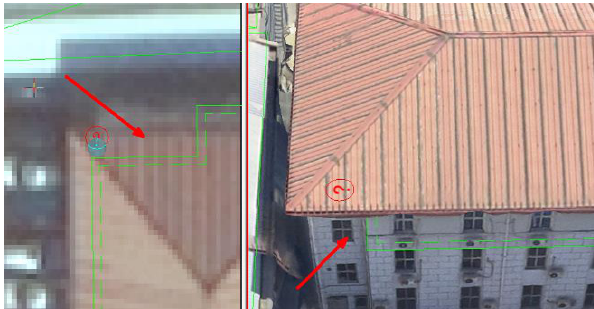
Figure 3 . Position acquisition accuracy of permanent house